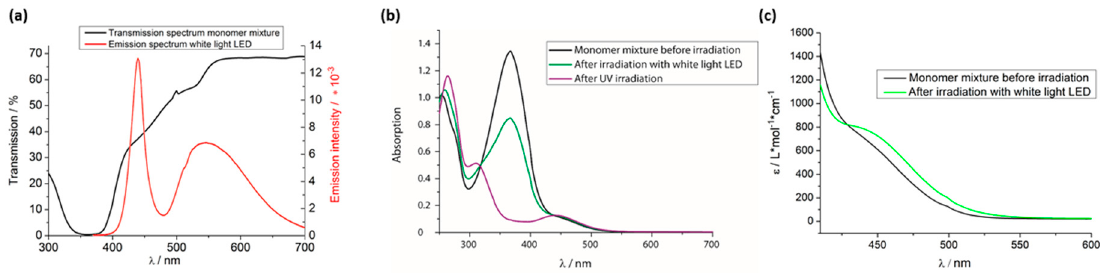
Figure 3. ( a ) The crosslinker’s transmission spectrum compared to the emission spectrum of the white light light-emitting diode (LED) which was used for the irradiation; ( b ) UV–vis spectrum of the monomer mixture before and after irradiation with UV light as well as after irradiation with the white light LED; ( c ) molar extinction coefficient spectrum of the monomer mixture before and after irradiation with the white light LED. All absorption/transmission spectra were measured at room temperature (RT) in dichloromethane (DCM).